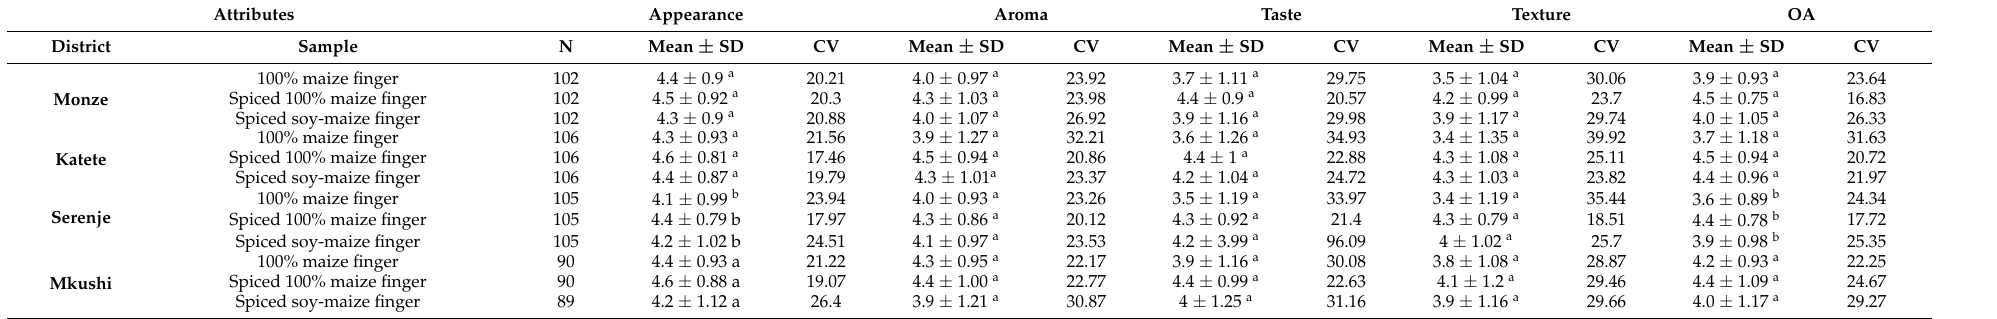
Table 7. Consumer preference ratings for maize finger products by district and across the